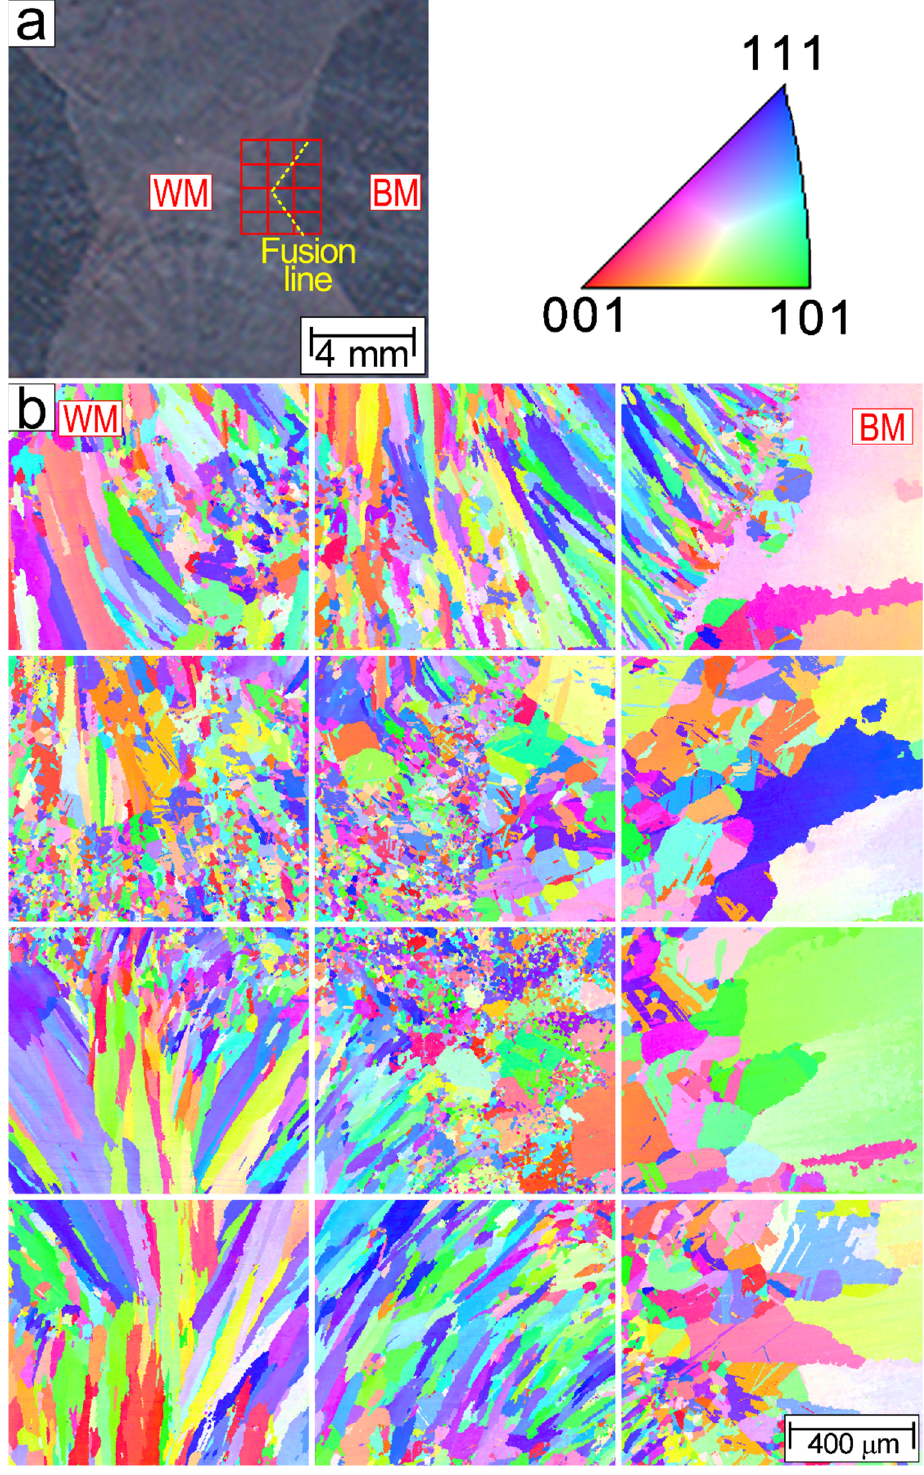
Figure 3. EBSD images mapping of the interface between WM and BM regions. Each square in the red matrix in ( a ) corresponds to each EBSD image in ( b ). The EBSD scale is the same for all EBSD images.